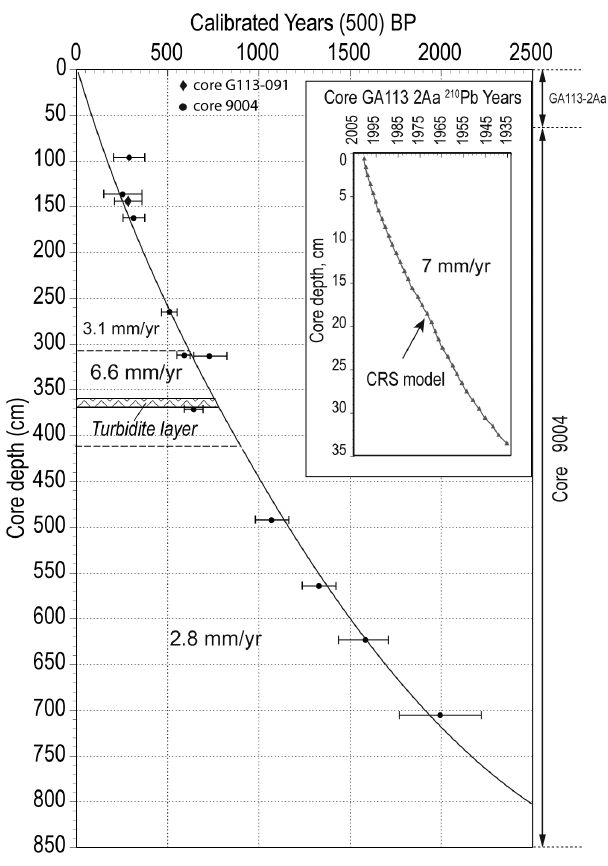
Fig. 2. Age model based on 210 Pb (core GA113-2Aa; Filipsson and Nordberg, 2004a) and 14 C AMS datings (core 9004; Filipsson and Nordberg, 2010). The new 14 C AMS dating for the core G113-091 is indicated by a diamond. In the revised version of 14 C age model (Polovodova et al., 2011) a 500-yr reservoir correction has been ap- plied, whereas a rectangle with a zigzag pattern at 357–371cm in- dicates the primary position of a turbidite, which was removed from the age curve. Separated by dashed lines are curve intervals, char- acterised by changes in a sedimentation